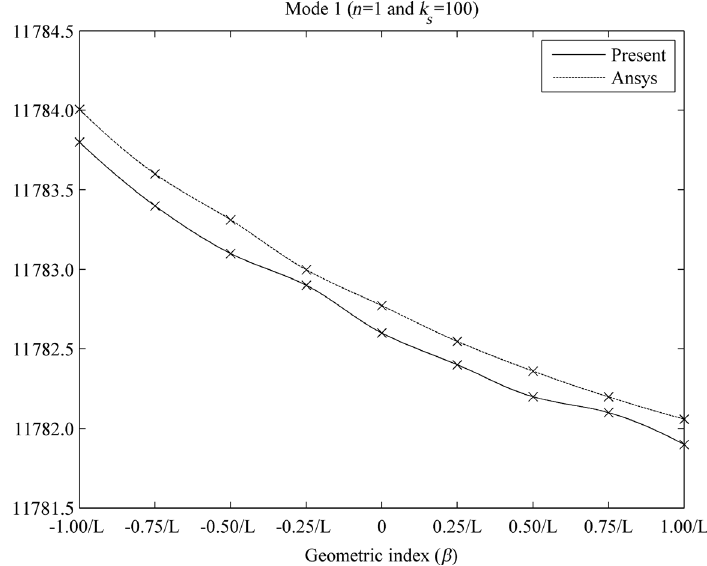
) for C-F boundary conditions ( β = -1/ L and n = s